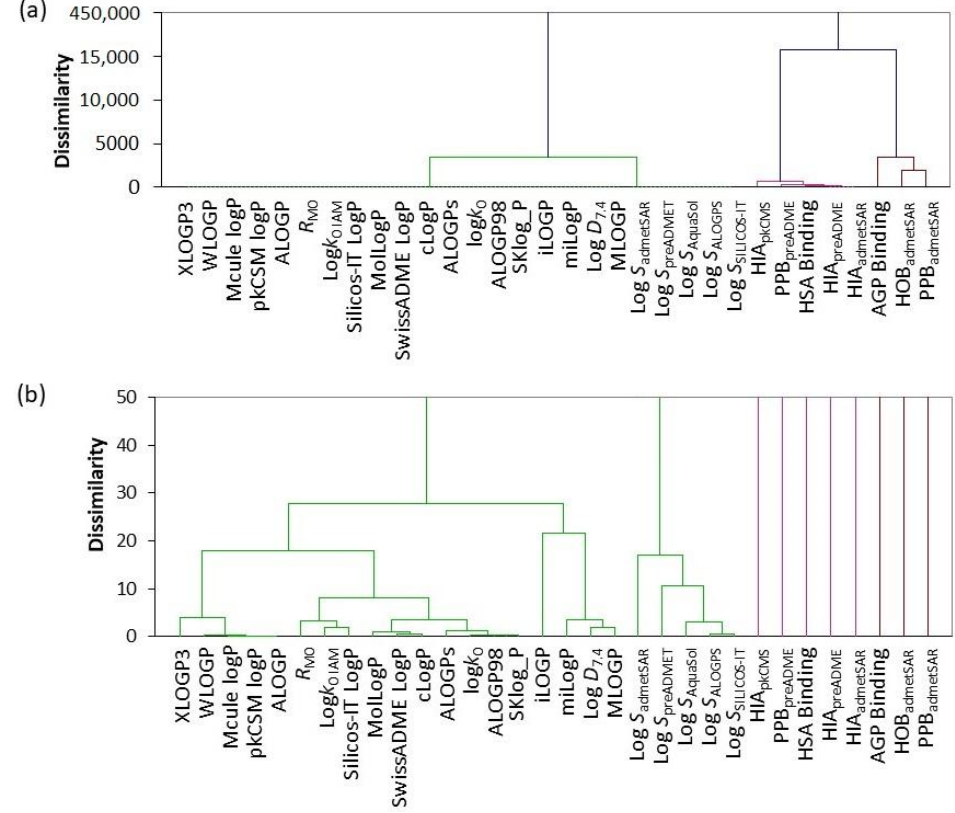
Figure 3. Results of CA showing ( a ) observed dendrogram in full scale from 0–450,000 with brake after 15,000, and ( b ) dendrogram showing only 0–50 range of dissimilarity values.